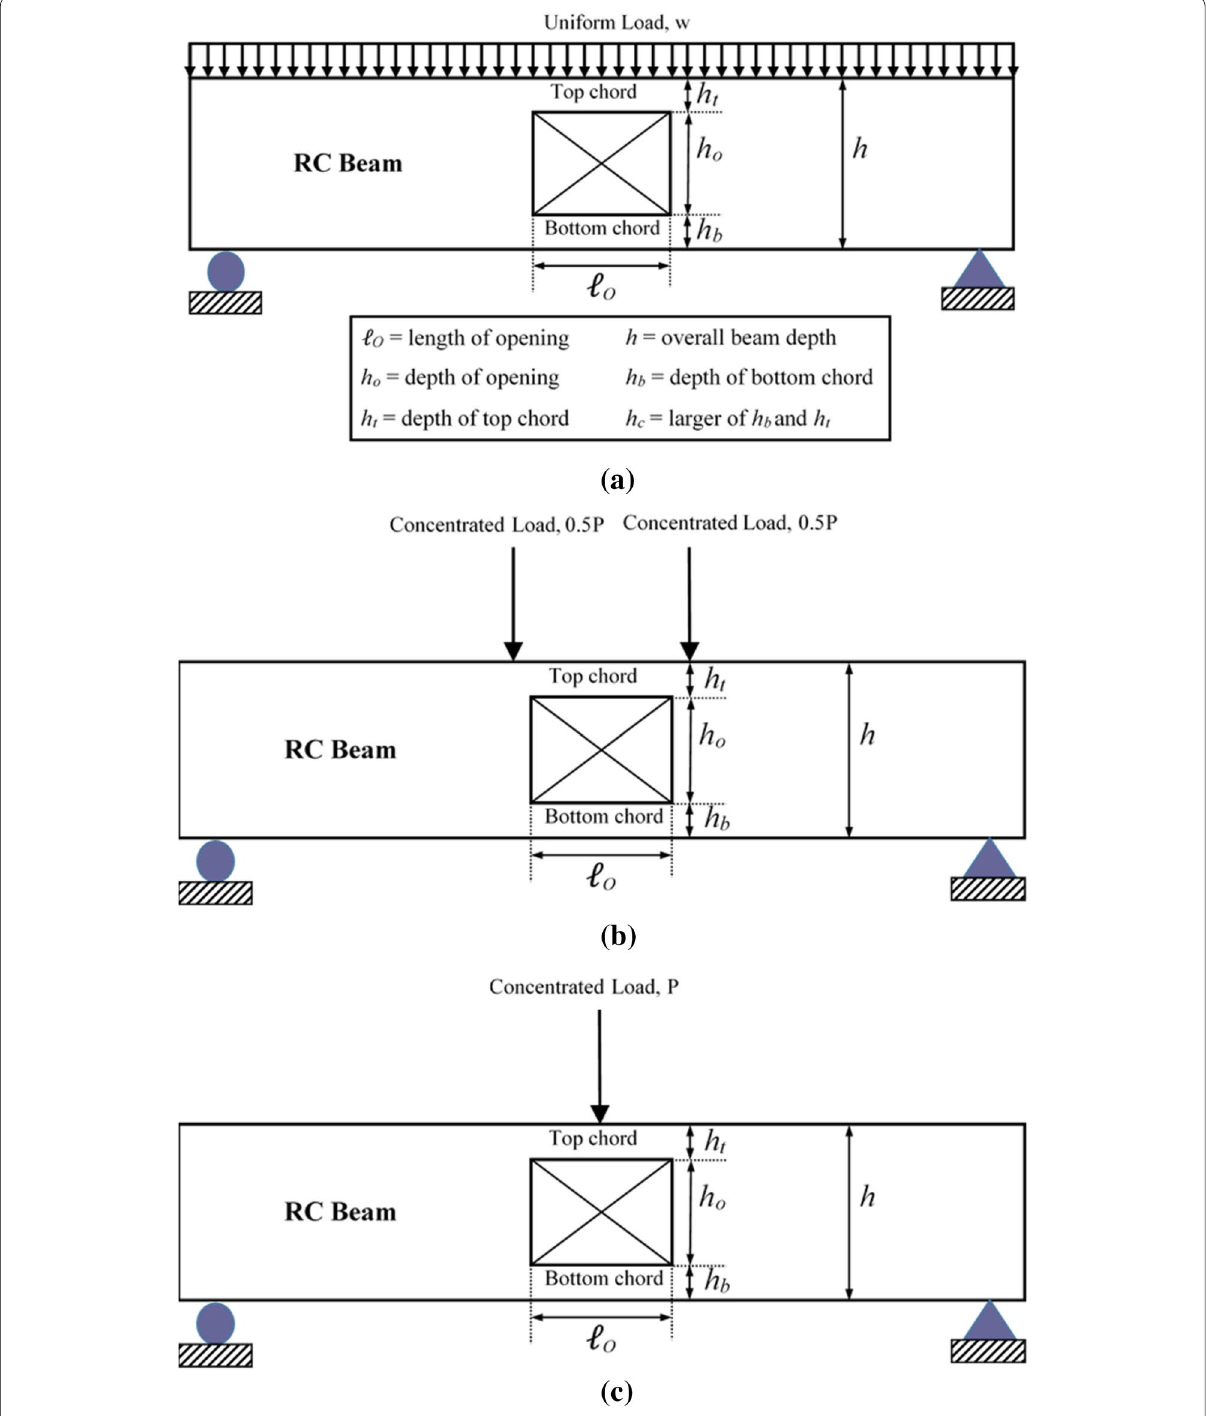
Fig. 1 Rectangular web opening in flexure zone of a simply supported RC beam: a opening in zone of high flexure with low shear (case of uniform load), b opening in zone of pure flexure with zero shear (case of 4‑point bending), and c opening in zone of high flexure with high shear (case of center‑point